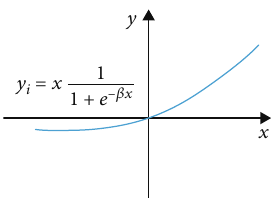
Figure 8: Swish function.